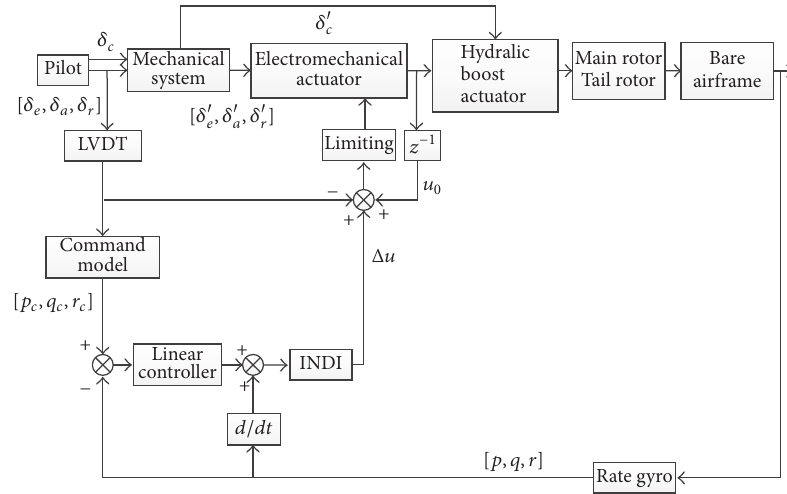
Figure 5: Implementation of RC mode into AH-64’s INDI control